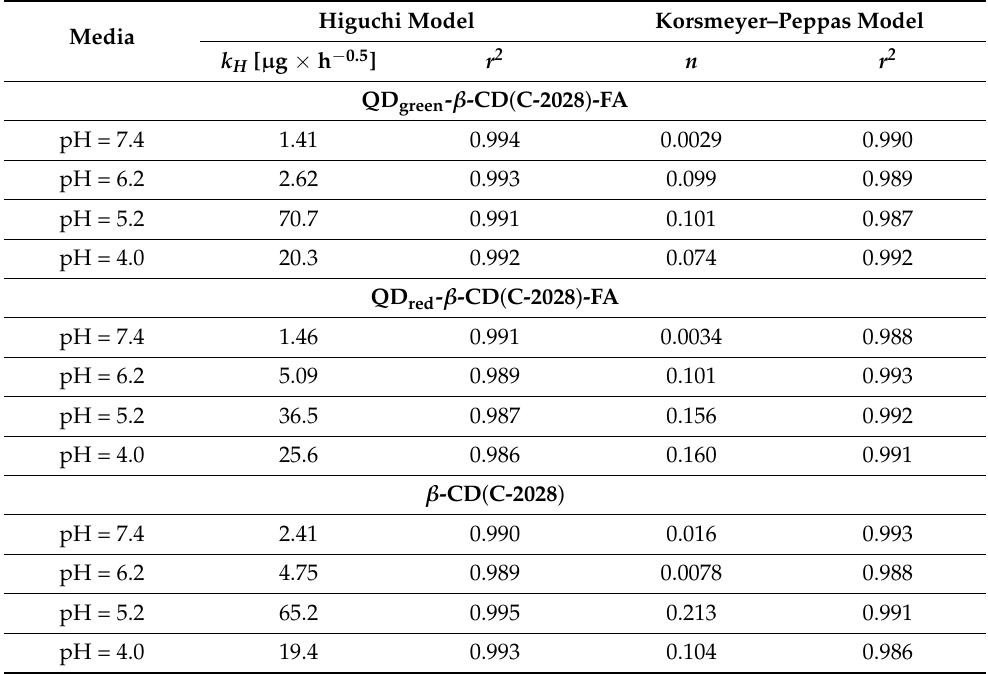
Table 1. Change in coefficient regression ( r ), release rate constant ( k H ), and release exponent ( n ) for the studied QDs- β -CD(C-2028)-FA